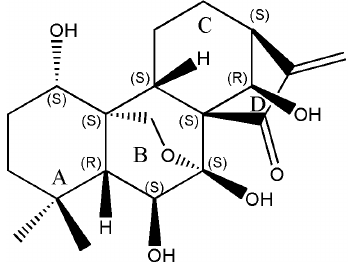
Figure 1. The compound structure of